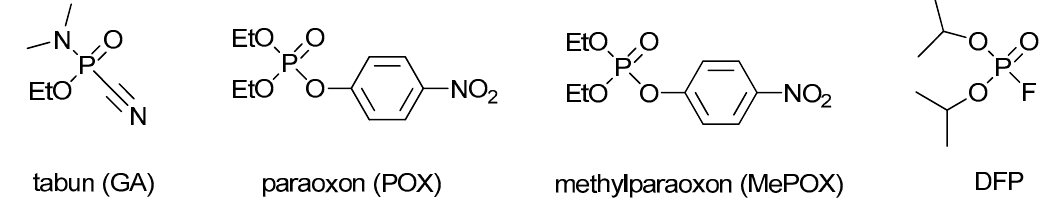
Figure 1. Selected organophosphorus compounds.